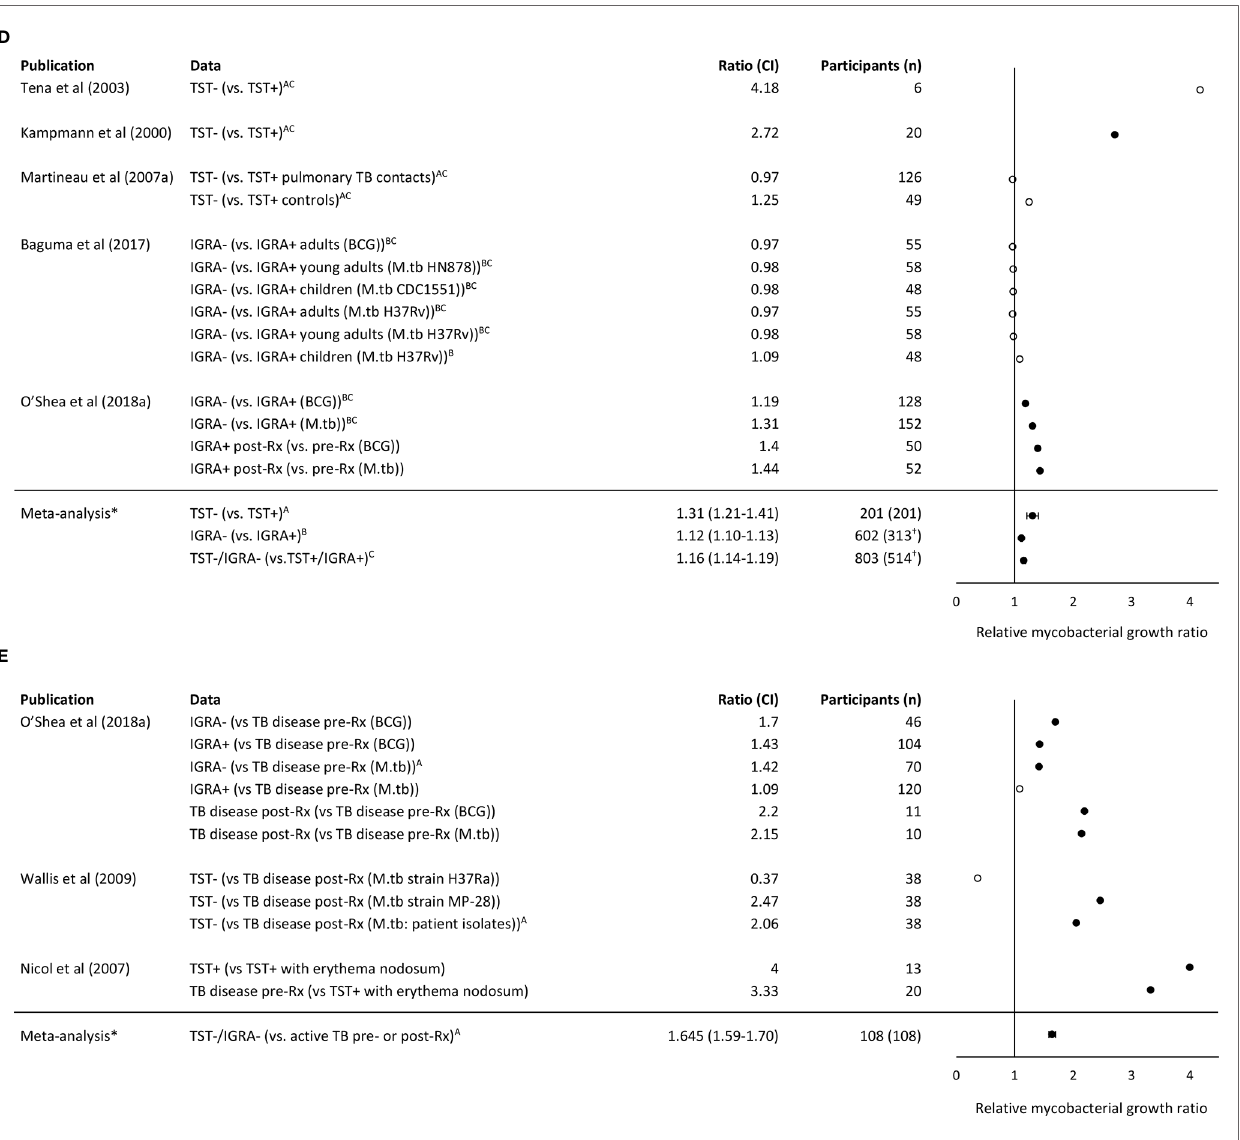
FIGURE 2 | (A) Relative mycobacterial growth ratios of comparisons made in studies of BCG vaccination. (B) Relative mycobacterial growth ratios of comparisons made in studies of parasitism, vitamin D, and altitude, respectively. +Note the Eisen et al. (8) considered growth relative to control samples to adjust for altitude effects on mycobacterial growth. (C) Relative mycobacterial growth ratios of comparisons made in studies of HIV and its treatment. (D) Relative mycobacterial † Approximation of population (E) Relative mycobacterial growth ratios of comparisons made in studies growth ratios of comparisons made in studies of TB infection. of TB disease. Note that higher relative mycobacterial growth ratio indicates greater mycobacterial growth so may be interpreted as implying relative susceptibility to mycobacterial infection in the participants listed without parentheses (compared with the participants listed in parentheses). Filled circles indicate P <0. 05. Meta- analysis mean and con fi dence interval methodology are explained in the Methods. BCG indicates Bacille Calmette Guerin. IGRA indicates the Interferon- g release assay. *Comparisons included in the meta-analysis are marked with the corresponding letter (A – C)